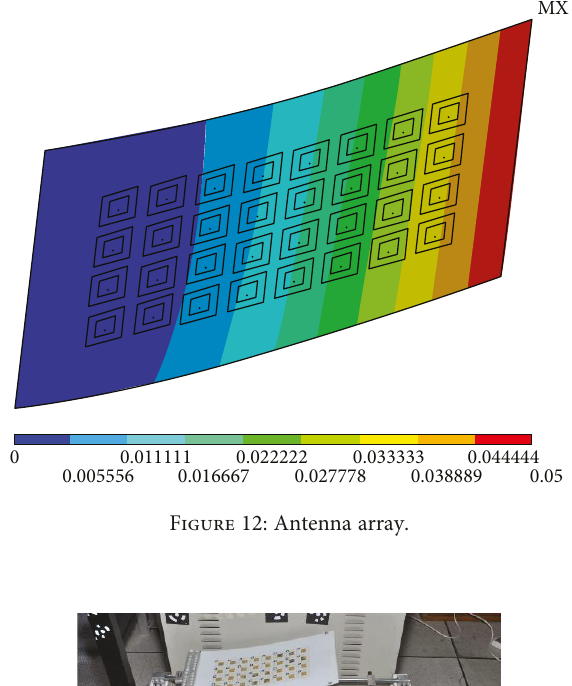
Figure 12: Antenna array.